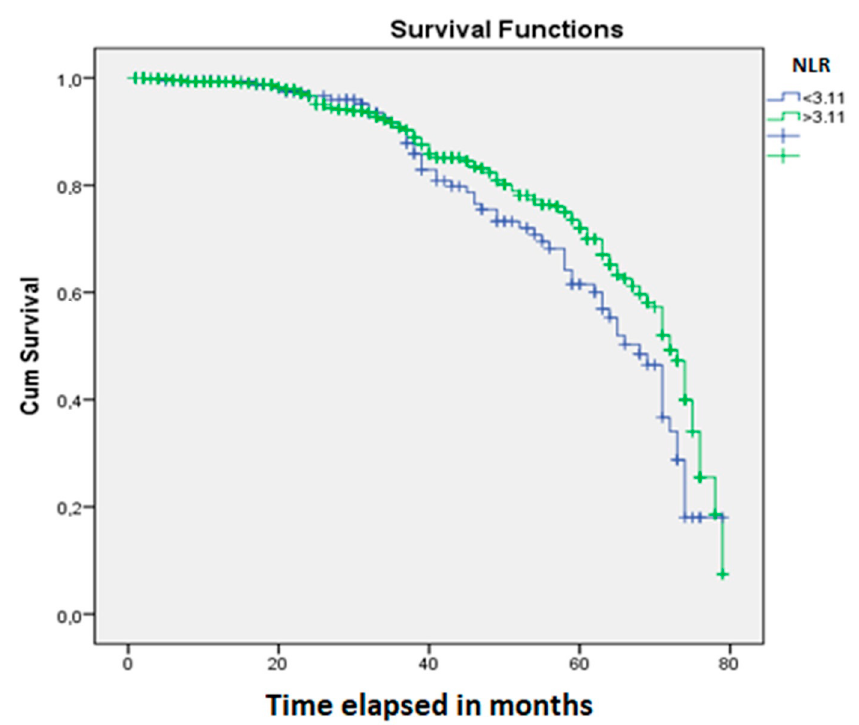
Figure 2. Neoadjuvant treatment significantly influences patients’ survival rate, compared to those who did not receive preoperative oncotherapy ( p = 0.0001).